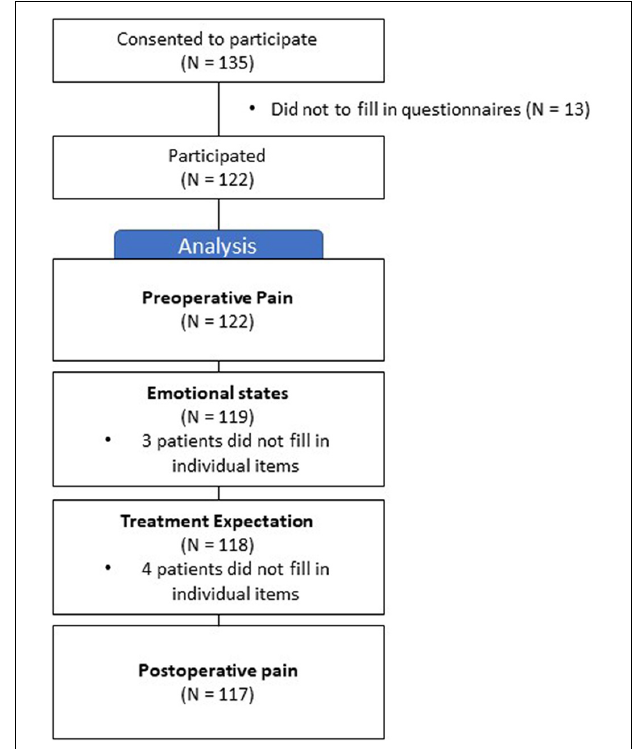
FIGURE 1 | Inclusion flow